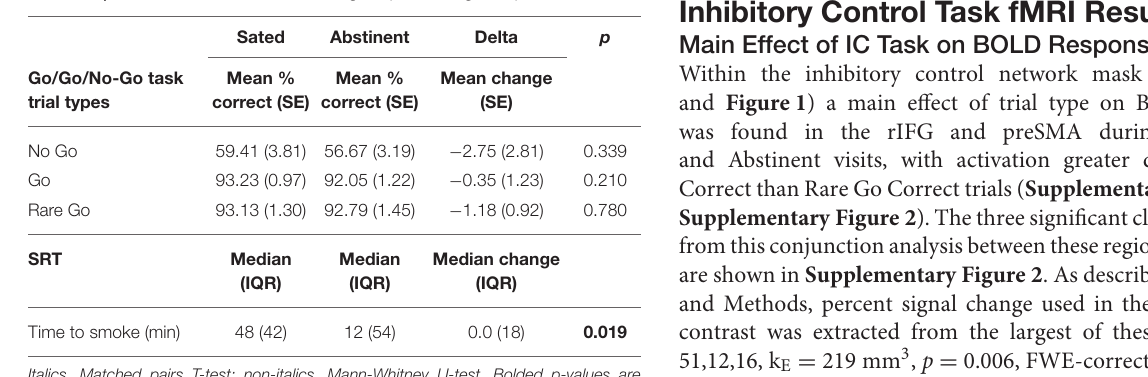
TABLE 3 | Go/Go/No-Go task and smoking relapse-analog task